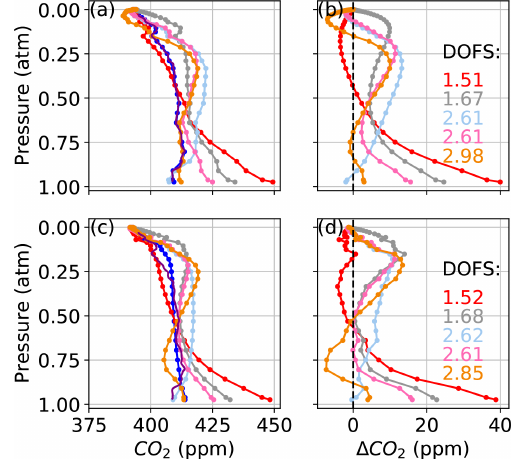
Figure 9. CO 2 profiles retrieved from spectra measured at the La- mont TCCON site on 14 January 2012, at 61–74 ◦ solar zenith an- gle, coincident with AirCore measurements using (a) the AirCore “truth” as a priori profiles and (c) the GGG2020 a priori profiles. In (b) and (d) the difference of the retrieved profiles minus the Air- Core profile is shown, corresponding to (a) and (c) , respectively. The points represent the 51 levels of the vertical grid. The DOFs for each retrieval window are indicated in (b) and (d) .